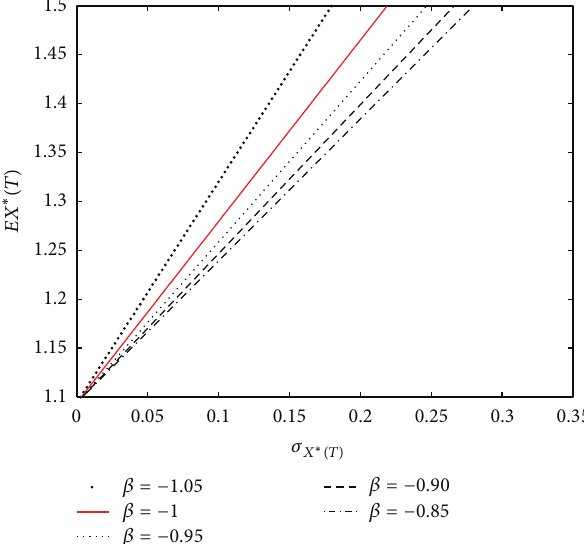
Figure 2: The efficient frontiers in mean-standard deviation plane ( 𝛽 = −1.05, . .. ,−0.85